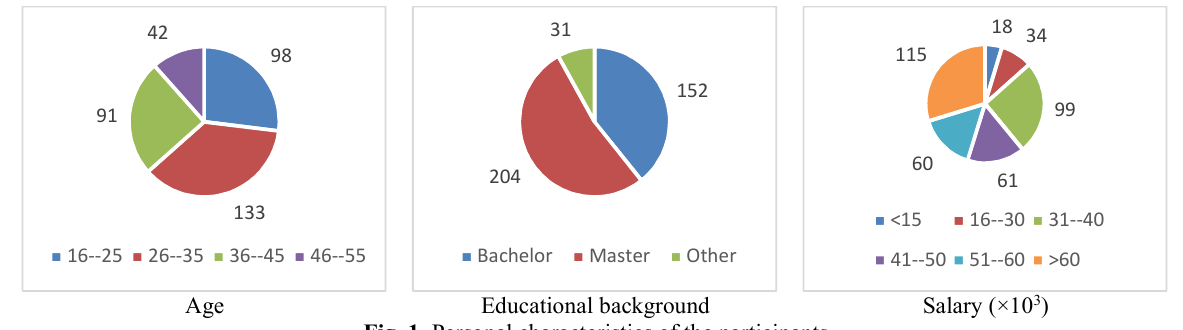
Fig. 1. Personal characteristics of the